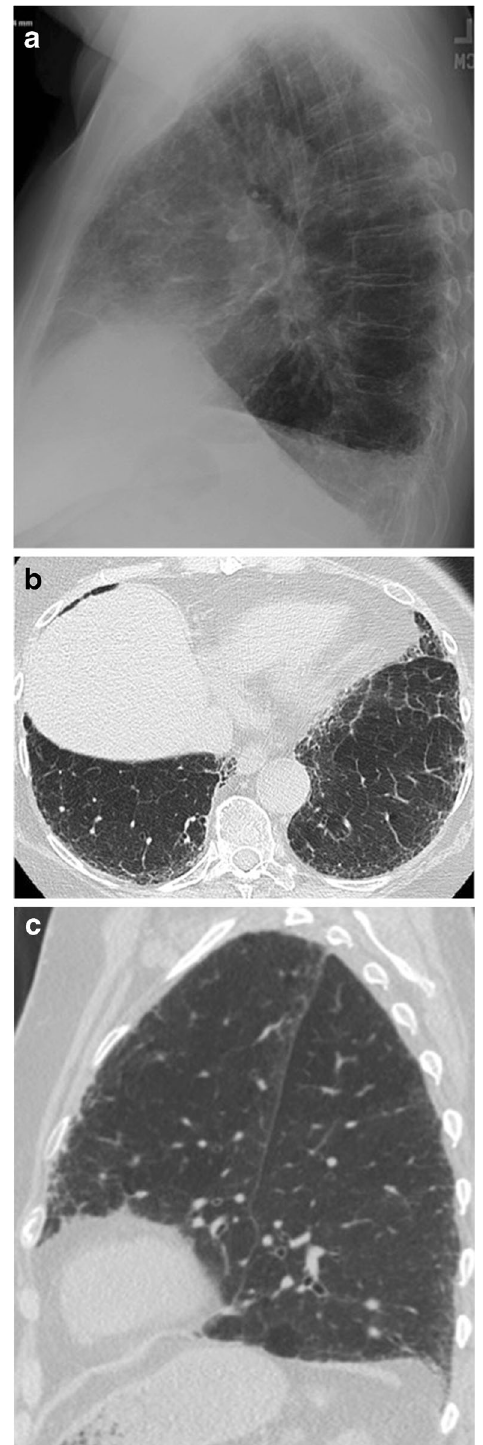
Fig. 7 84-year-old woman with idiopathic pulmonary fibrosis. On the lateral radiograph (a), reticular opacities are easily seen through an opaque retrosternal space. Although the retrocardiac space is more lucent, reticular opacities are not seen at the lung bases, despite the basilar predominance typical of UIP demonstrated on axial (b) and sagittal (c) CT